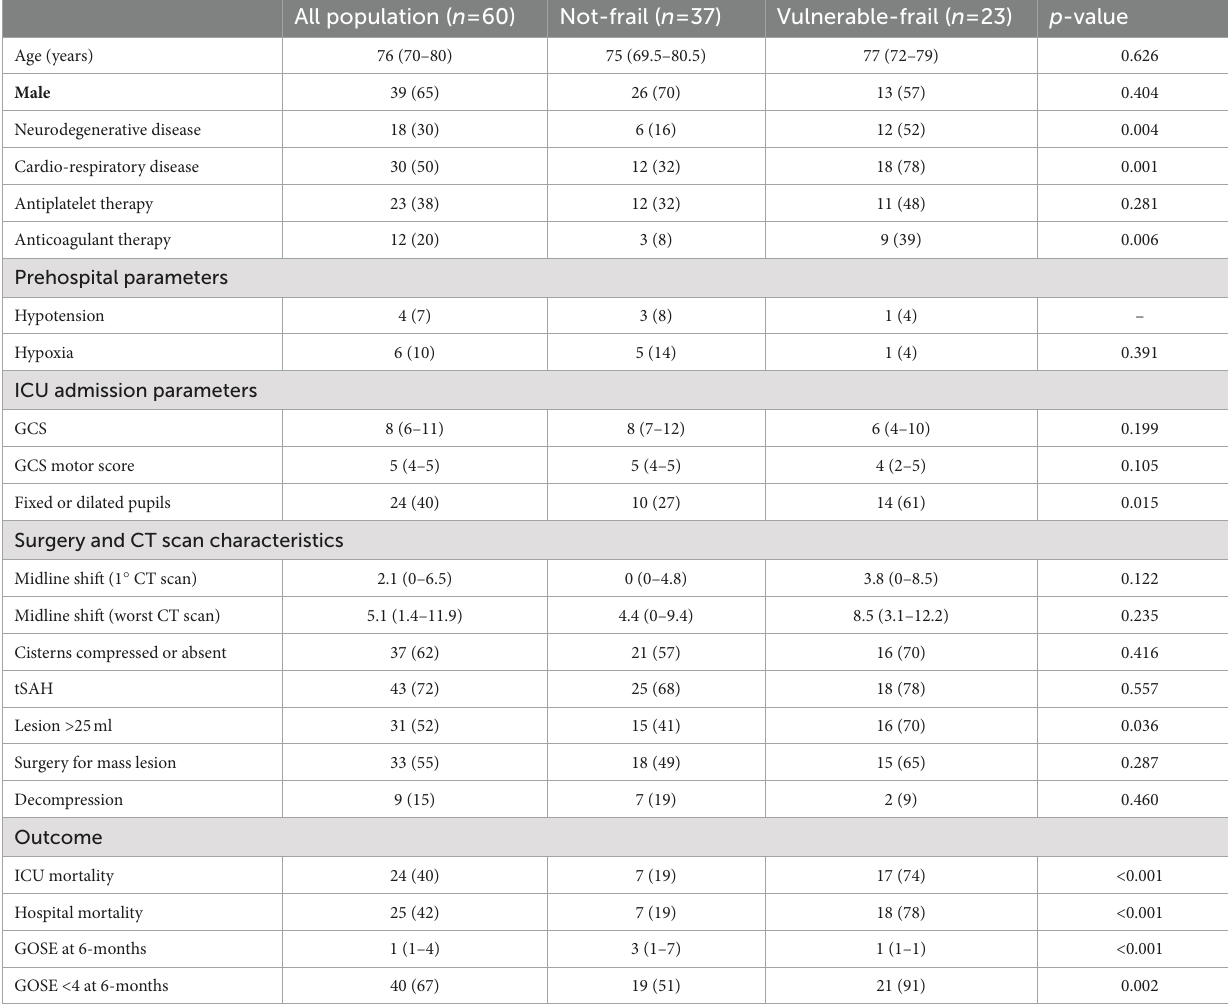
TABLE 1 Demographic characteristics, clinical and radiological parameters, surgical management and outcome of patients. All population ( n = 60) Not-frail ( n = 37) Vulnerable-frail ( n =